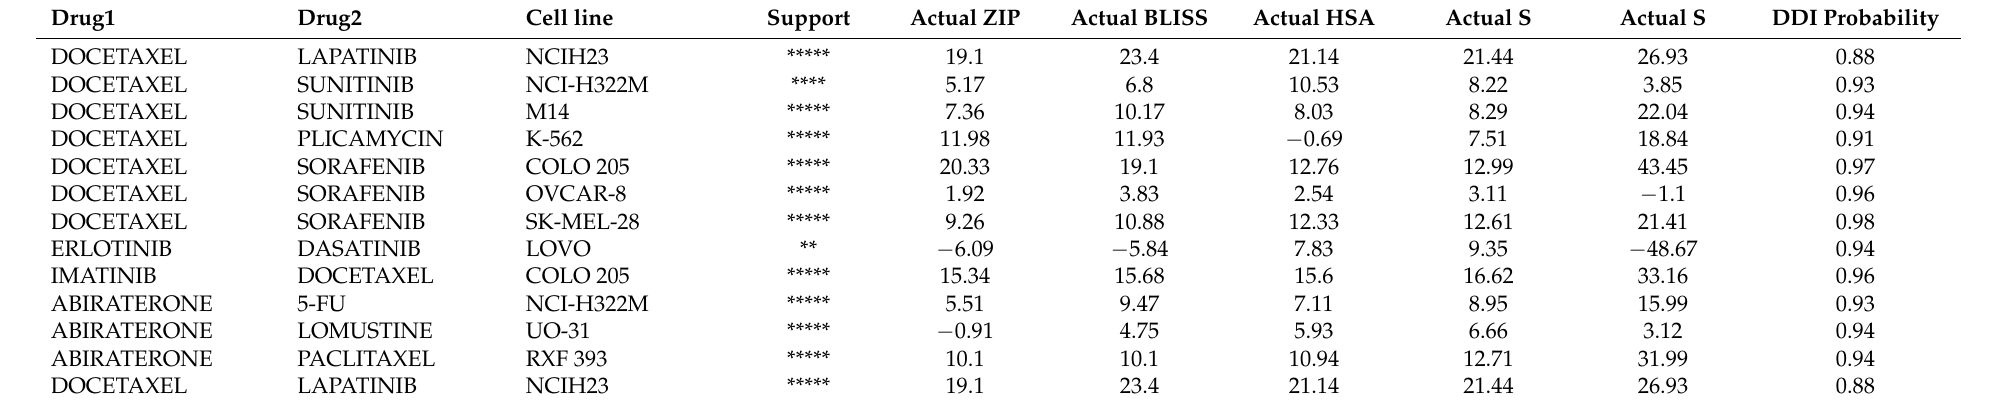
Table 6. The drug combinations predicted with synergistic and adverse DDIs. DDI probability refers to the DEML predictive probability in DDI classification